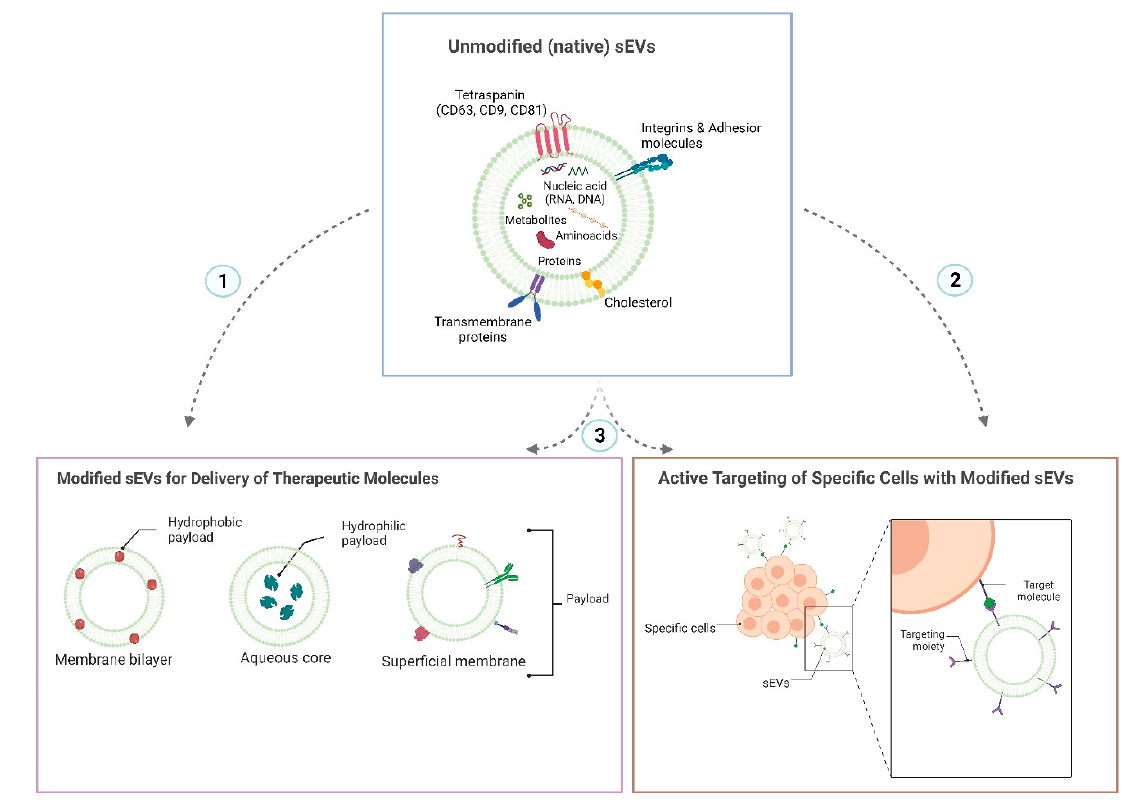
Figure 1. Diagram of the native structure of small extracellular vesicles and the functionalization strategies that can be performed on them to provide them with specific therapeutic properties. Small extracellular vesicles (sEVs) have a structure formed by a membrane composed of a lipid bilayer. Different proteins are expressed in it, which may be common to the vast majority of sEVs (such as tetraspanins for sEVs derived from eukaryotic cells) or specific proteins according to the origin of their parental cell. The core of sEVs is composed of nucleic acids, lipids, proteins, and metabolites. One of the characteristics of sEVs that make them good nanocarriers is that they can be easily modified to endow them with specific therapeutic properties. For example, to acquire a certain therapeutic efficacy, sEVs can be engineered to carry a specific therapeutic payload: drugs, proteins, or different types of nucleic acids (siRNA, miRNA, shRNA). Depending on the molecule’s type and therapeutic function to be triggered, the payload can be incorporated into or anchored to the surface of the sEVs membrane. It can also be loaded into the sEVs core (1). To provide them with a better safety profile, sEVs can be functionalized to target a specific cell or tissue by incorporating a targeting moiety into their surface membrane (2). This strategy reduces off-target interactions while improving the bioavailability of the therapeutic molecule at the site of interest. Both the strategy of therapeutic loading molecules and the strategy of targeting sEVs to a specific tissue can be performed together in sEVs (3), providing the nanovesicles with better efficacy and safety profiles at the same time (created with http://www.biorender.com (accessed on 16 november 2022)).